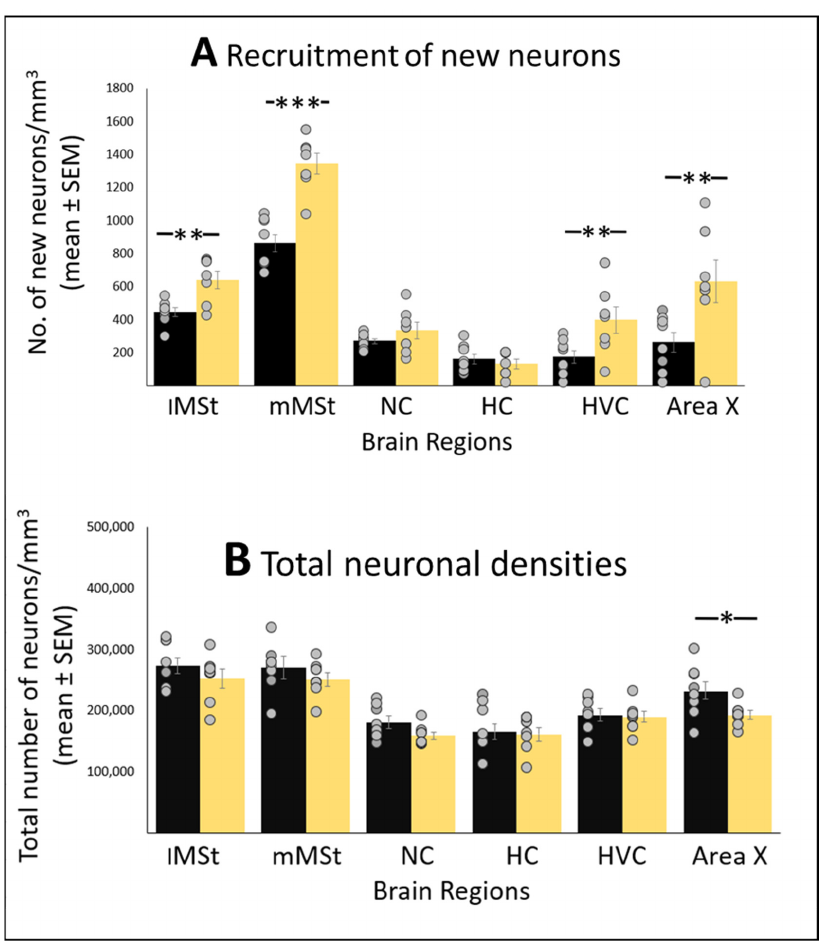
Figure 7. ( A ) Neuronal recruitment (number of new neurons mm 3 ; mean ± SE) and ( B ) Total neuronal densities (number of neurons/mm 3 ± SE) in the lMSt (lateral medial striatum), mMSt (medial medial striatum), NC (nidopallium caudale), HC (hippocampus), HVC and Area X, in brains of birds exposed to 5 lux ALAN, and controls that were kept under complete darkness at night. Grey dots indicate individual data points; *, **, ***—indicate significant differences ( p < 0.05, p < 0.005, and p < 0.0005 respectively; Tukey post hoc tests following one-way ANOVAs for each section separately). n = 8 birds per group.